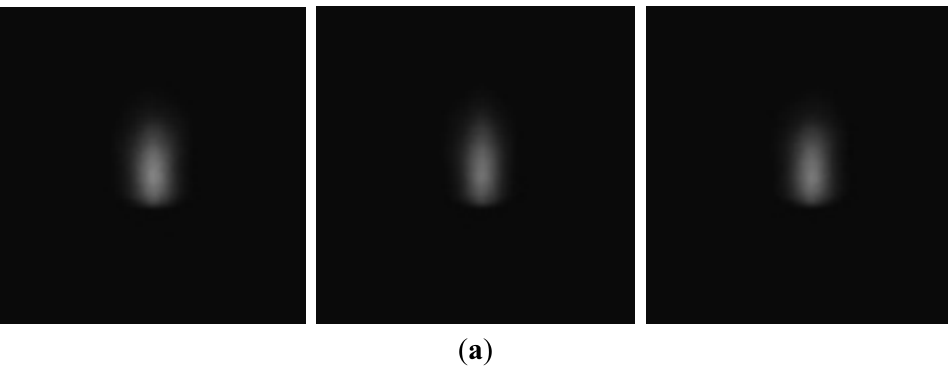
Figure 2. Plasma region of image of Al 5052 ( a ) acquired by CMOS camera and ( b ) after